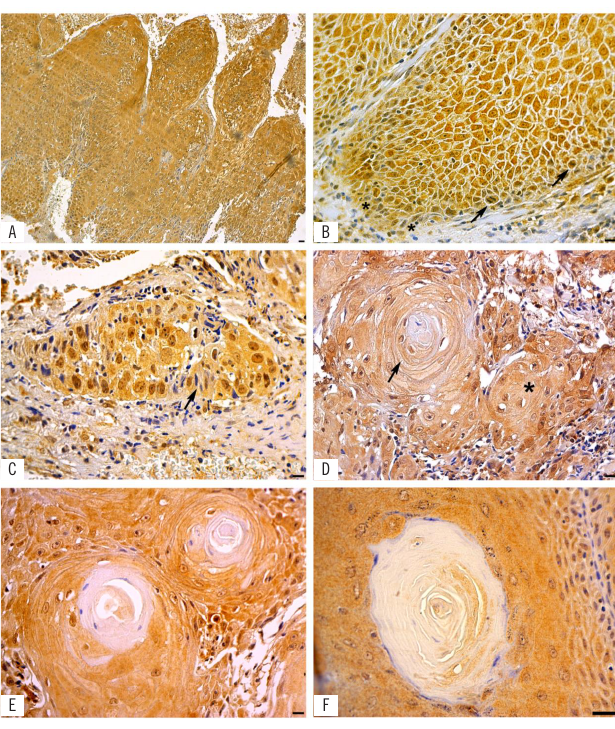
Figura 2: Fotomicrografias de imunomarcação para TIMP-1 em CCE Grau I. (A) Visão FIGURE 2 – Immunolabeling photomicrographs for TIMP-1 in stage I SCC panorâmica com expressão da molécula no estroma e no parênquima, sendo nesse A) panoramic view with molecule expression in the stroma and parenchyma, more intense último mais intensa. (B) Camadas mais profundas da lesão com marcação intensa em in the latter; B) deeper layers of the lesion with intense labeling on pleomorphic cells and células pleomórficas e em mitoses (setas), células com perda de polaridade mitosis (arrows); cells with loss of polarity showed weaker labeling ( * ); C) tumor island with apresentaram marcação mais fraca (*). (C) Ilha tumoral com células apresentando variação na expressão de TIMP-1, sendo que as menos diferenciadas tiveram cells showing variation in TIMP-1 expression – the less differentiated ones presented weaker marcação menor (seta). Células do estroma ao redor da ilha pouco marcadas. (D) labeling (seta); stromal cells around the island weakly labeled; D) keratin pearl formation Pérola córnea em formação (*) e a estrutura propriamente dita (seta), exibindo padrões ( * ) and the actual structure (arrow), showing different TIMP-1 expression patterns; de expressão de TIMP-1 diferentes. (E e F) Presença de pérolas córneas bem E and F) presence of well-organized keratin pearls, with intense labeling on peripheral organizadas, com marcação intensa nos queratinócitos periféricos e marcação bem keratinocytes and very weak or absent labeling on central cells; scale bar = 20 µm. fraca ou ausente nas células centrais. Barra de escala = 20  m. TIMP-1: tissue inhibitor of metalloproteinase-1; SCC: squamous cell